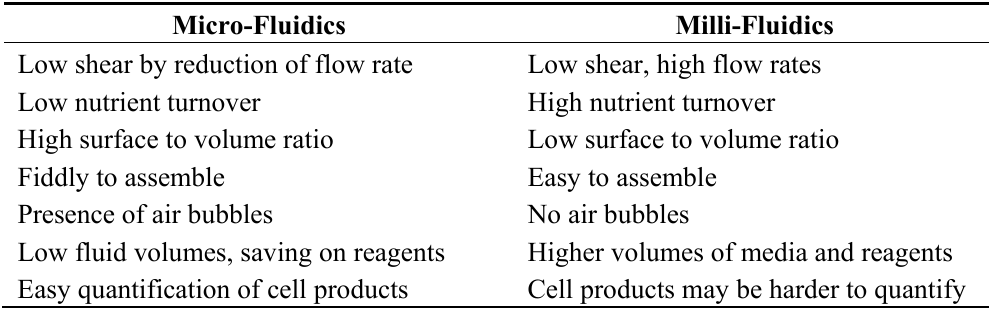
Table 2. Comparison between the milli- and micro-fluidic